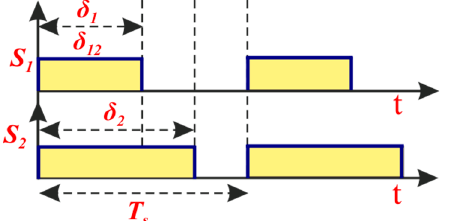
Figure 6. Left-aligned switching pattern.